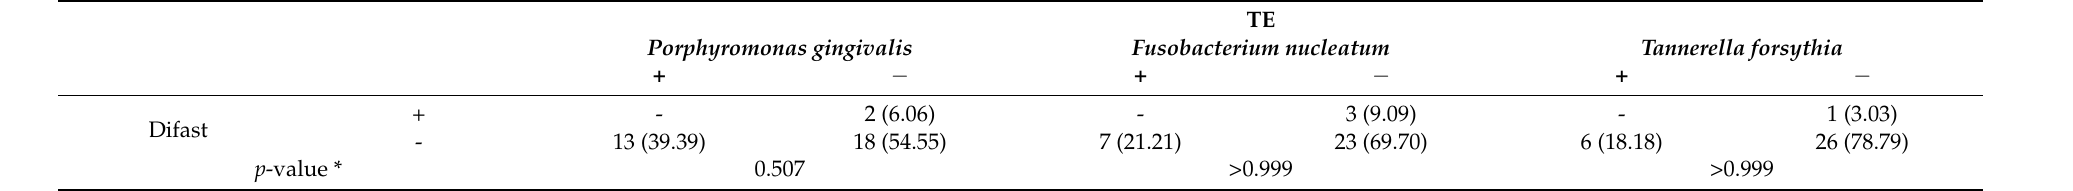
Table 3. Comparison of the periopathogen detection by LAMP depending on the medium (TE or Difast